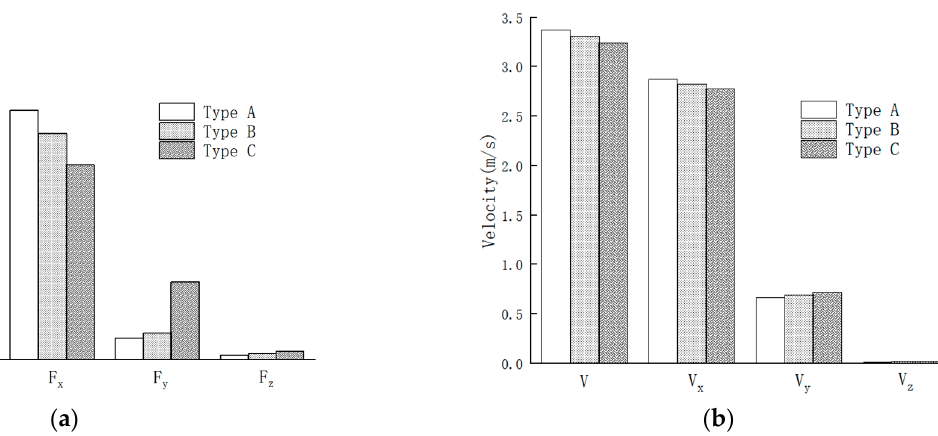
Figure 16. Force and motion characteristics of particles: ( a ) particle stress and ( b ) particle velocity. Notes: F is the combined force of the seeds; F x is the force in the X direction of the seed; F y is the force in the X direction of the seed; F z is the force in the Z direction of the seed; V is the combined velocity of the seeds; V x is the speed of the seed in the X direction; V y is the speed of the seed in the Y direction; V Z is the speed of the seed in the Z